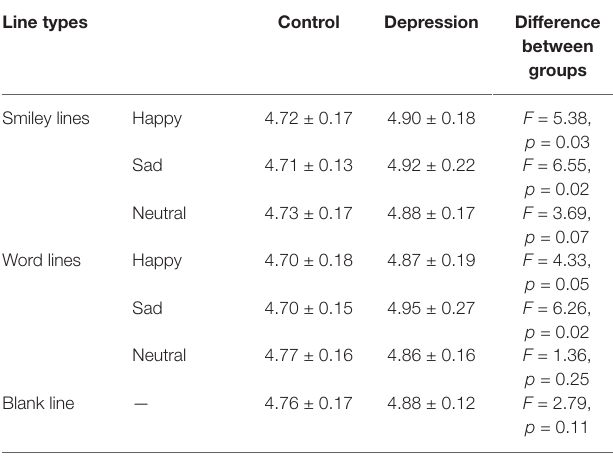
TABLE 2 | Deviations in bisection of radial lines (measurements are the distance from the distal end in centimeters. The midline is 5 cm, proximal deviation is more than 5 cm, and distal deviation is less than 5